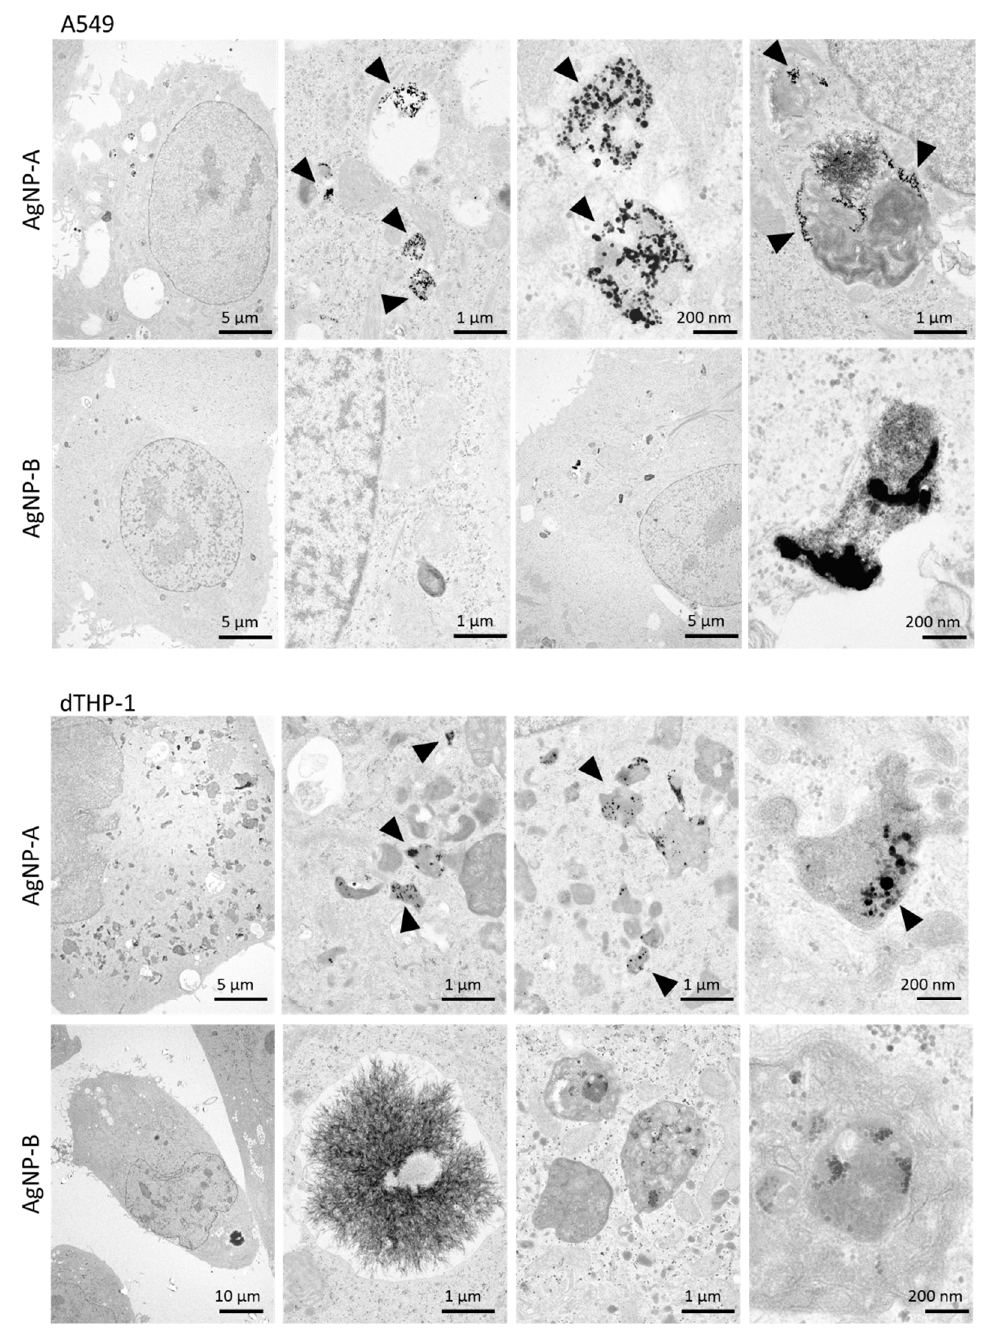
Figure 1. TEM observation of AgNP-treated cells. A549 and dTHP-1 cells were exposed to AgNP suspensions for 24 h at 10 µ g/mL. Intracellular putative AgNPs were indicated by